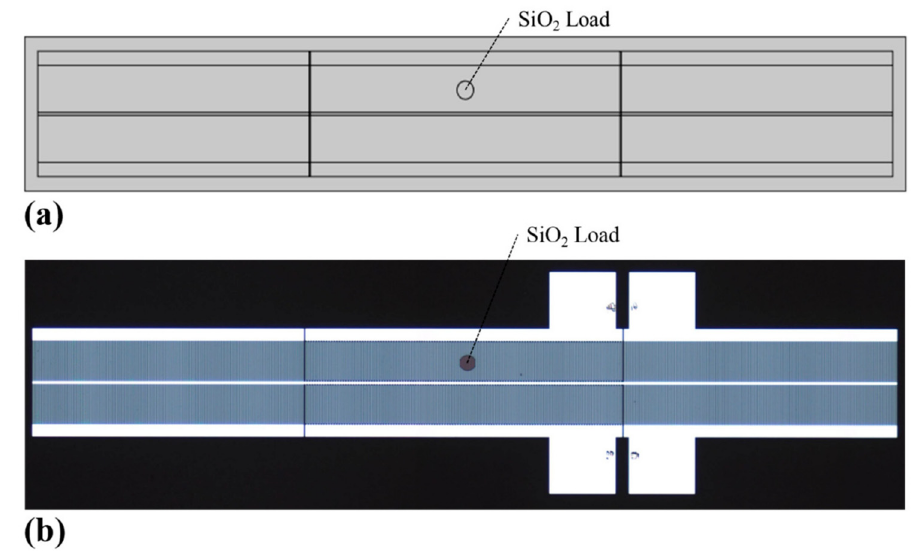
Figure 8. ( a ) Geometric model of TC-SAWR with SiO 2 load constructed in COMSOL; ( b ) fabricated TC-SAWR device with SiO 2